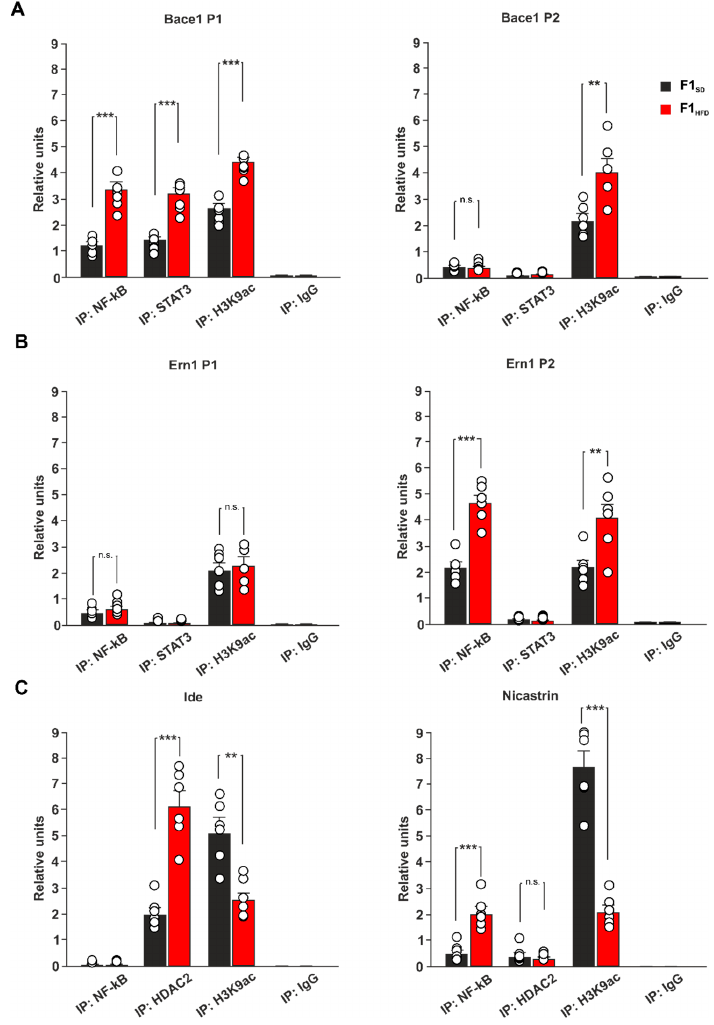
Figure 4. Ancestor HFD induced epigenetic alteration in the promoters of genes involved in AD onset and pathogenesis. ( A ) ChIP assays of NF-kB, STAT3 and H3K9ac on two different promoters of Bace1 gene in F1 SD and F1 HFD 3xTg-AD mice (n = 6; statistics by one-way ANOVA and Bonferroni post hoc). ( B ) ChIP assays of NF-kB, STAT3 and H3K9ac on two different promoters of Ern1 gene in F1 SD and F1 HFD 3xTg-AD mice (n = 6; statistics by one-way ANOVA and Bonferroni post hoc). ( C ) ChIP assays of NF-kB, STAT3 and H3K9ac on the promoters of Ide and Nicastrin genes in F1 SD and F1 HFD 3xTg-AD mice (n = 6; statistics by one-way ANOVA and Bonferroni post hoc). IgG are used as negative controls. Real-time analysis was performed in triplicate. Data are expressed as mean ± SEM. ** p < 0.01; *** p < 0.001; n.s. not significant.